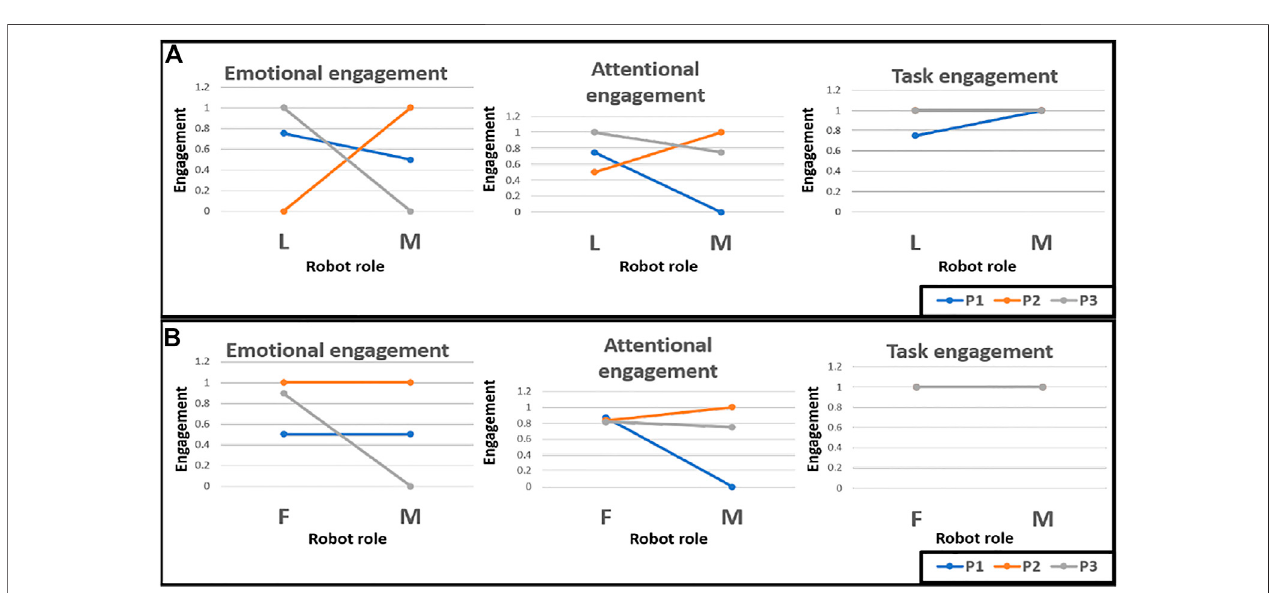
FIGURE 5 | Changes in the raw values of the engagement components under the single-role and mixed-role designs, where (A) shows the changes between the leader role only vs mixed-role conditions, and (B) shows the changes between the follower role only vs mixed-role conditions. P1, P2 and P3 are the three participants from our user study (L, Leader, (F) Follower, M,